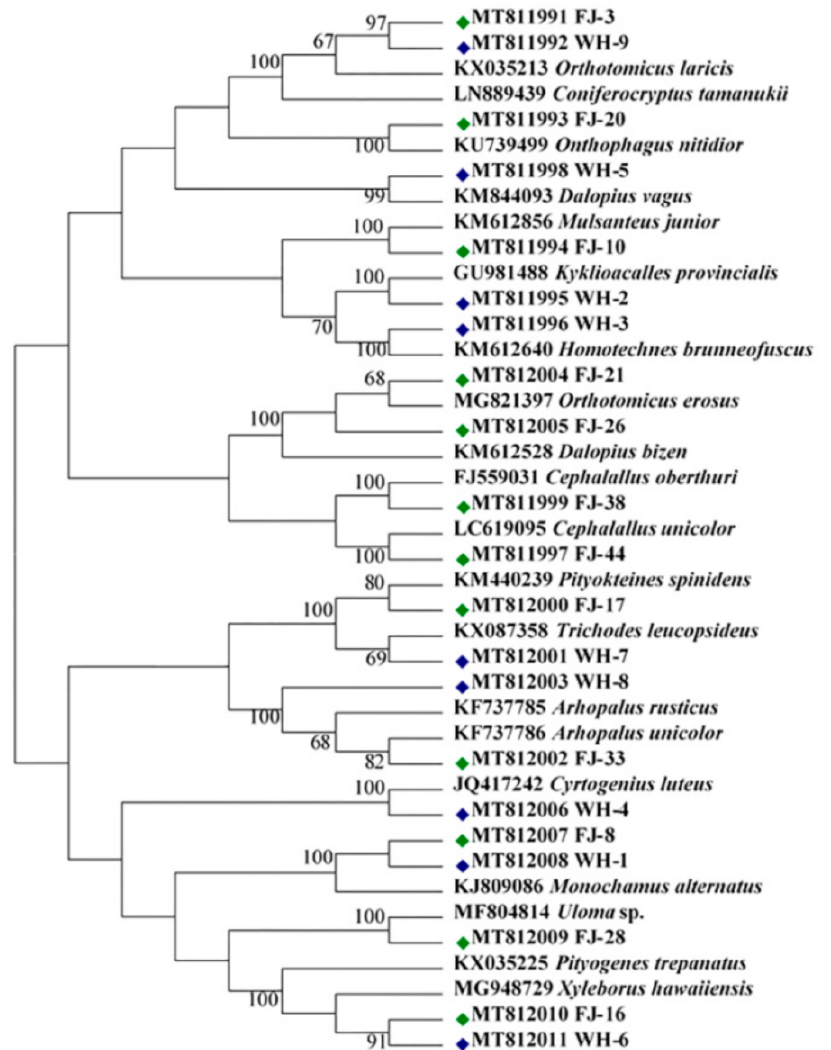
Figure 1. Phylogenetic tree based on the COI sequences of 20 xylophagous beetles collected from pine infected with PWN. FJ1–FJ12 labeled on green dots indicates xylophagous beetles collected from P. massoniana Lamb.; WH1–WH9 labeled on blue dots indicates xylophagous beetles collected from P. thunbergii Parl.; others indicate the reference